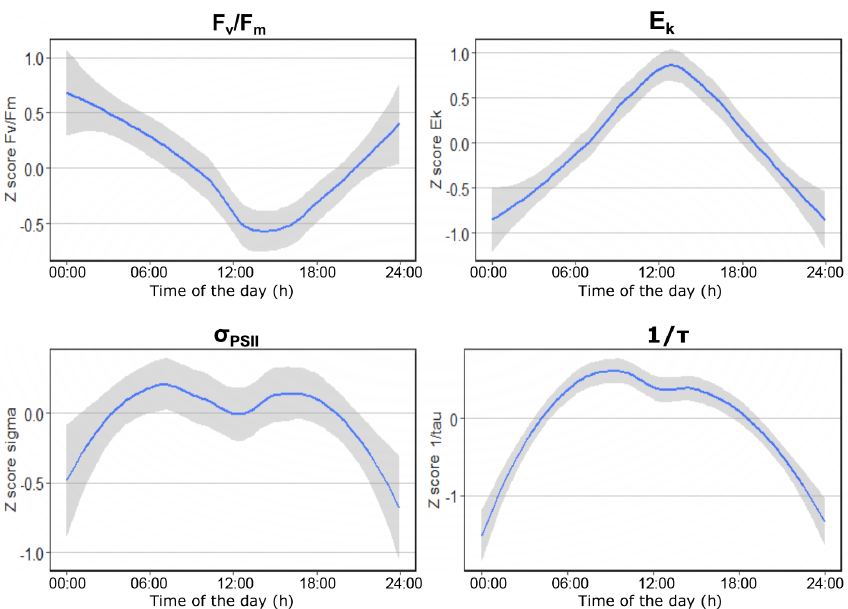
Figure 5. Standardized daily anomalies ( z scores) of F v /F m , E k , σ PSII , and 1 /τ showing the diurnal trends in photophysiological data. On the x axis is the time of the day and on the y axis is the z score. Figure made using the ggplot2 package in R (Wickham,